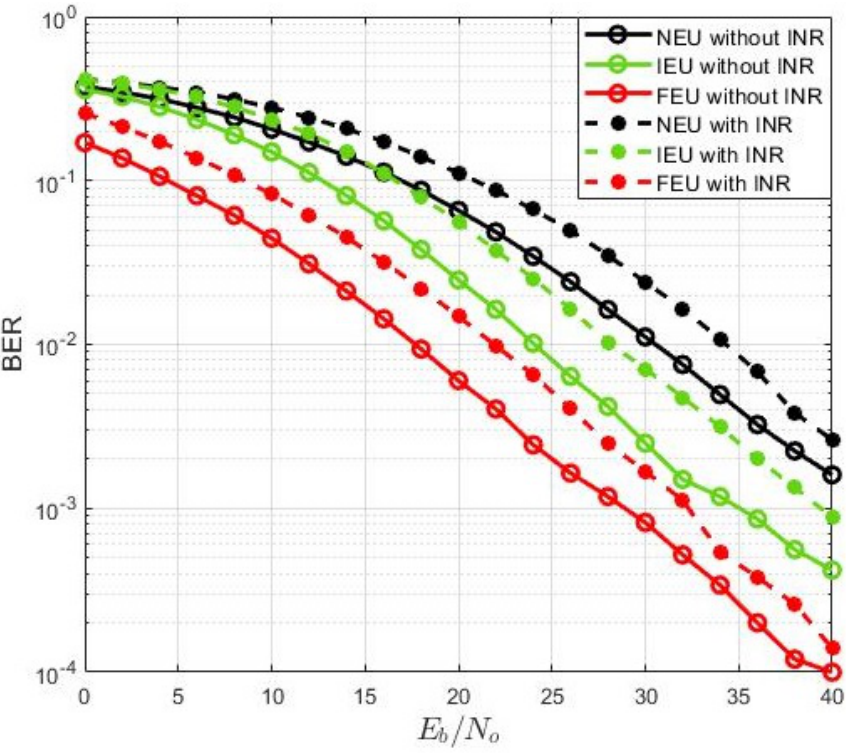
Figure 16. BER performance comparison of perfect SIC for more than 2 users in the presence of intercell